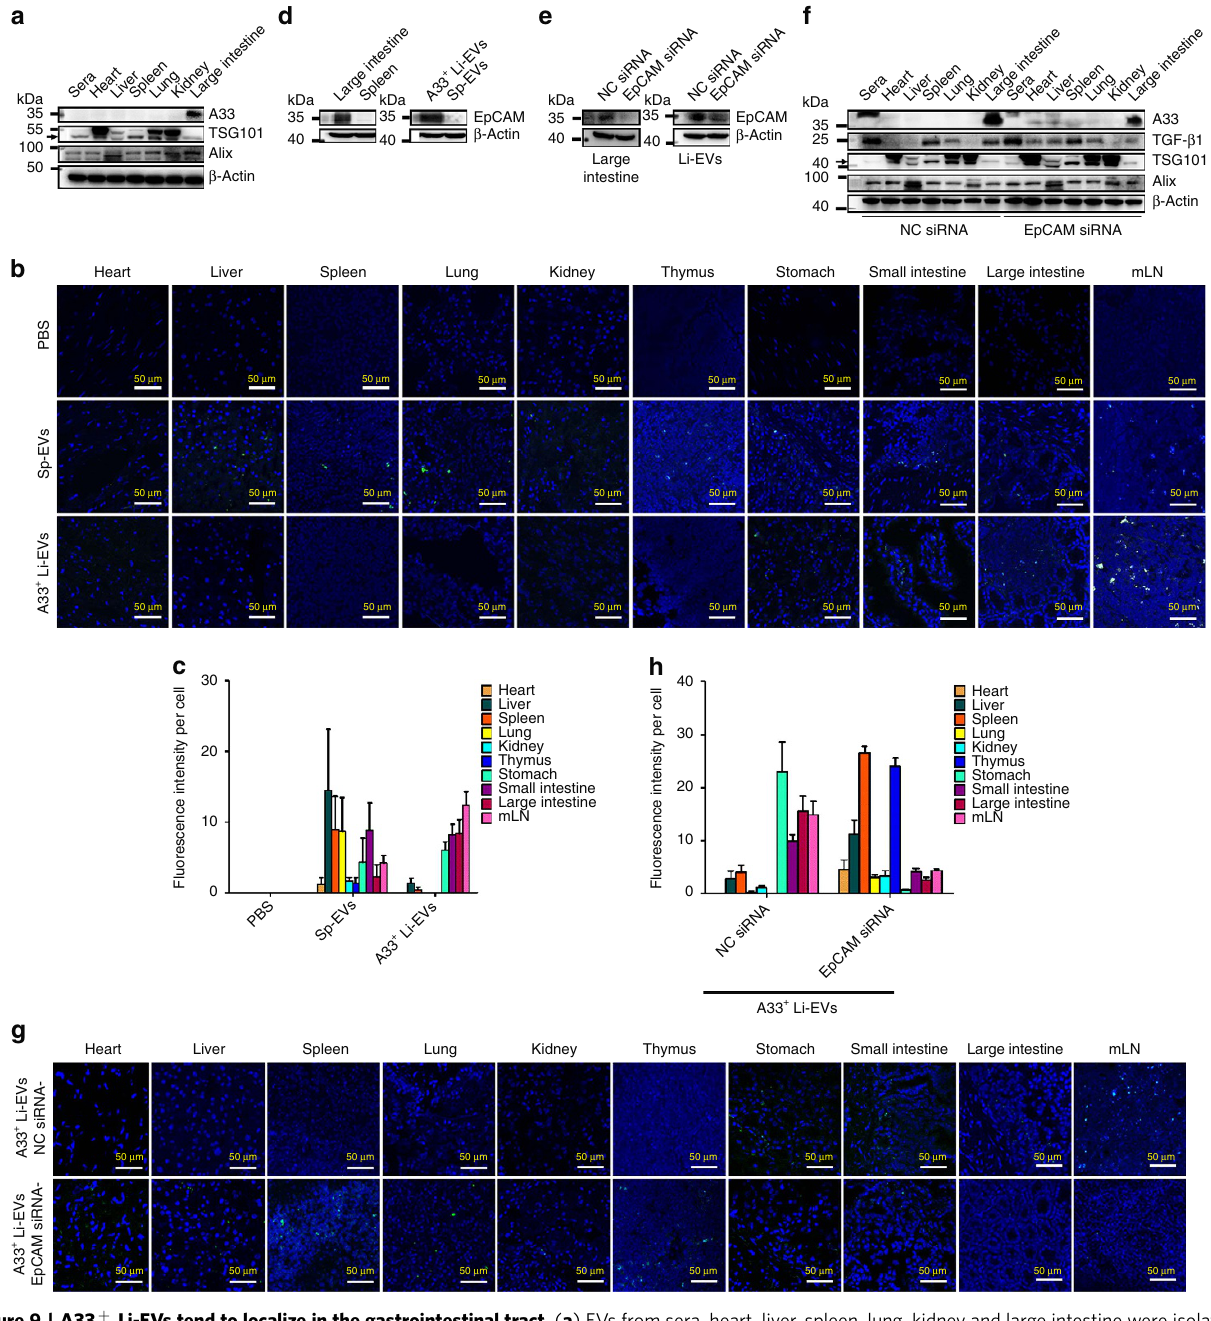
Figure 9 | A33 þ Li-EVs tend to localize in the gastrointestinal tract. ( a ) EVs from sera, heart, liver, spleen, lung, kidney and large intestine were isolated. A33, TSG101, Alix and b -Actin in these EVs were measured using western blot analysis. ( b ) Each mouse received one intravenous injection of 100 m g CFSE-labelled A33 þ Li-EVs, mice were killed 4h later and distribution of CFSE-labelled A33 þ Li-EVs in the indicated organs was detected with an immunofluorescence assay. ( c ) Quantification of the mean green fluorescence intensity per cell ( n ¼ 3). ( d ) EpCAM protein levels in spleen lysates, large intestine lysates, Sp-EVs and A33 þ Li-EVs were measured using western blot analysis. ( e – g ) Mice were intrarectally injected with 20 m g cholesterol- conjugated EpCAM or NC siRNA for three consecutive days. Twenty-four hours after the last injection, mice were killed and A33 þ Li-EVs were isolated. EpCAM protein levels in lysates of large intestine, and A33 þ Li-EVs were measured using western blot analysis ( e ). EVs from sera, heart, liver, spleen, lung, kidney and large intestine were isolated. A33, TGF- b 1, Alix, TSG101 and b -Actin in these EVs were detected using western blot analysis ( f ). Each mouse received one intravenous injection of 100 m g CFSE-labelled EpCAM siRNA-A33 þ Li-EVs or NC siRNA-A33 þ Li-EVs, mice were killed 4h later and distribution of CFSE-labelled EVs in the indicated organs was detected with an immunofluorescence assay ( g ). ( h ) Quantification of the mean green fluorescence intensity per cell ( n ¼ 3). Data are representative of two independent